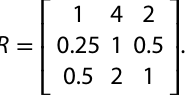
Table 1 Pairwise comparison table that is completed by the customer